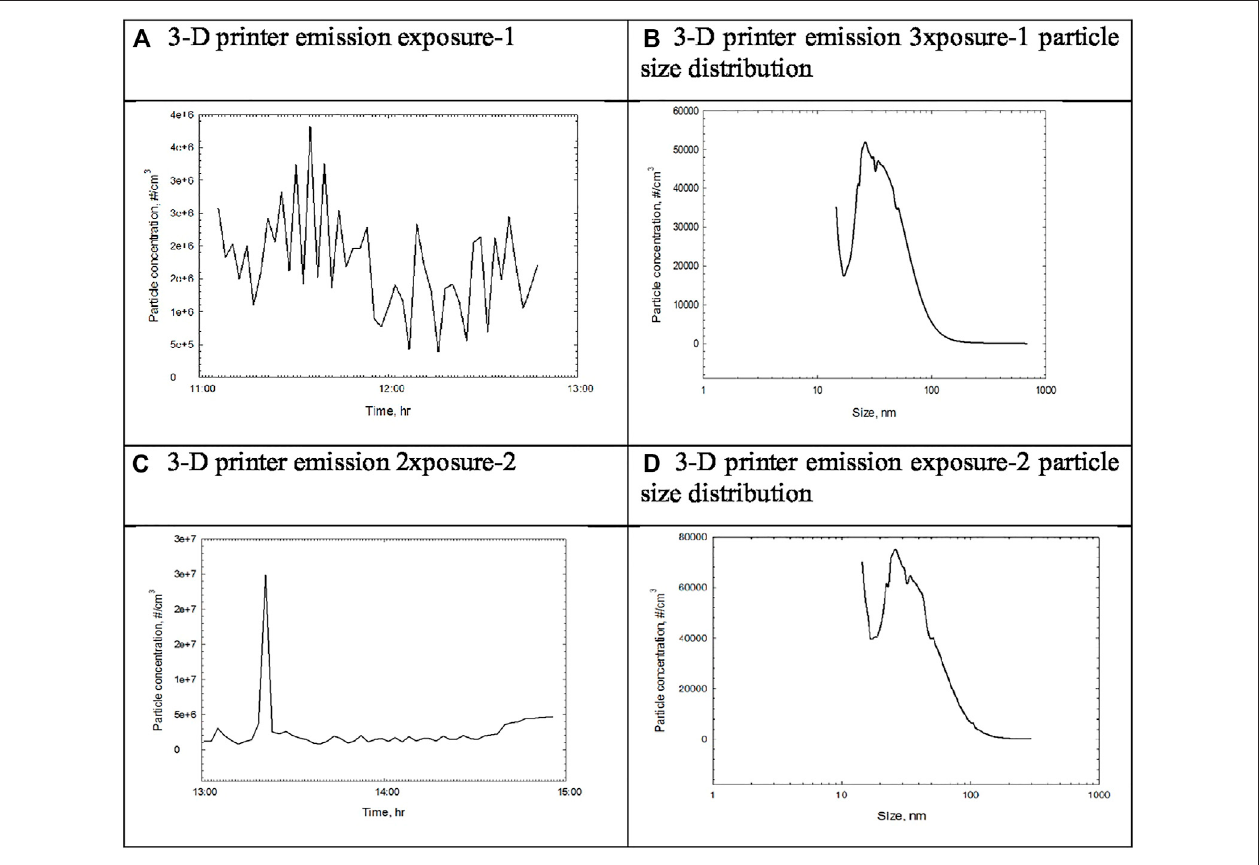
FIGURE 2 | Particle concentration and size distribution measured by DMAS during the 2-h exposure of 3-D printer emission. (A) 3-D printer emission exposure-1. (B) 3-D printer emission eposure-1 particle size distribution. (C) 3-D printer emission exposure-2. (D) 3-D printer emission exposure-2 particle size distribution.